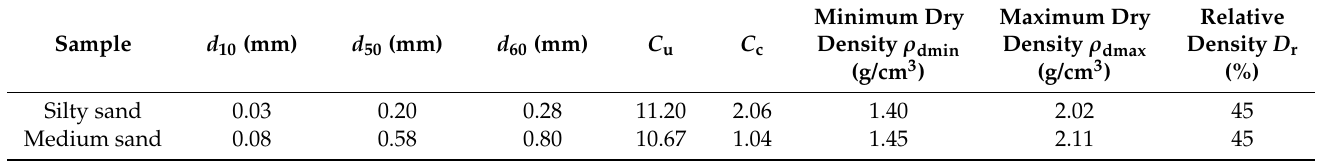
Table 2. Physical parameters of the silty sand and medium